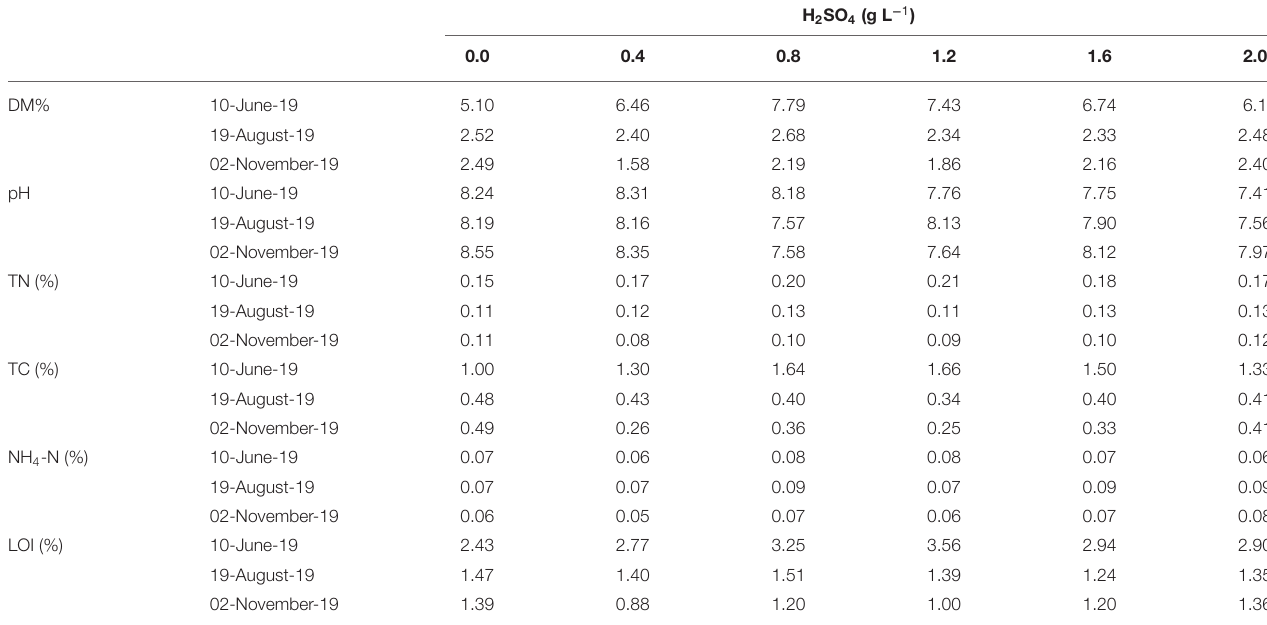
TABLE 1 | Dry matter (DM, %), pH, total nitrogen (TN, %), total carbon (TC, %), ammonia-N (NH 4 -N, %), loss on ignition (LOI, %) of dairy slurries at the start of the trial (10 Jun), mid-trial (19 Aug), and end of the trial (02 Nov) in response to different rates of H 2 SO 4 (g L − 1 slurry)